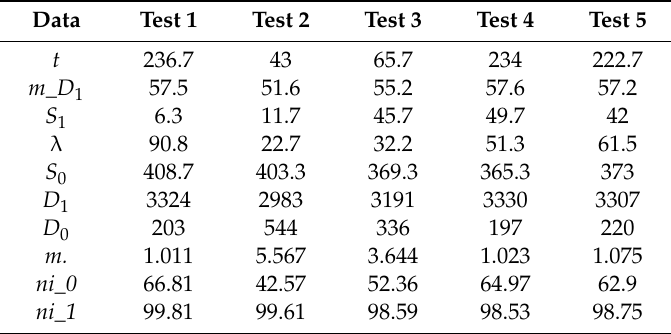
Table 7. Sorting results on sorting